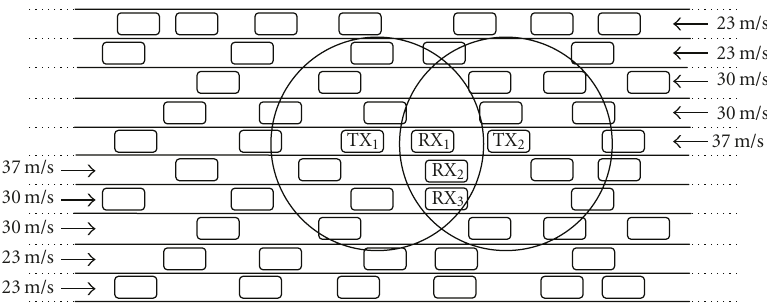
Figure 4: Simulation setup.